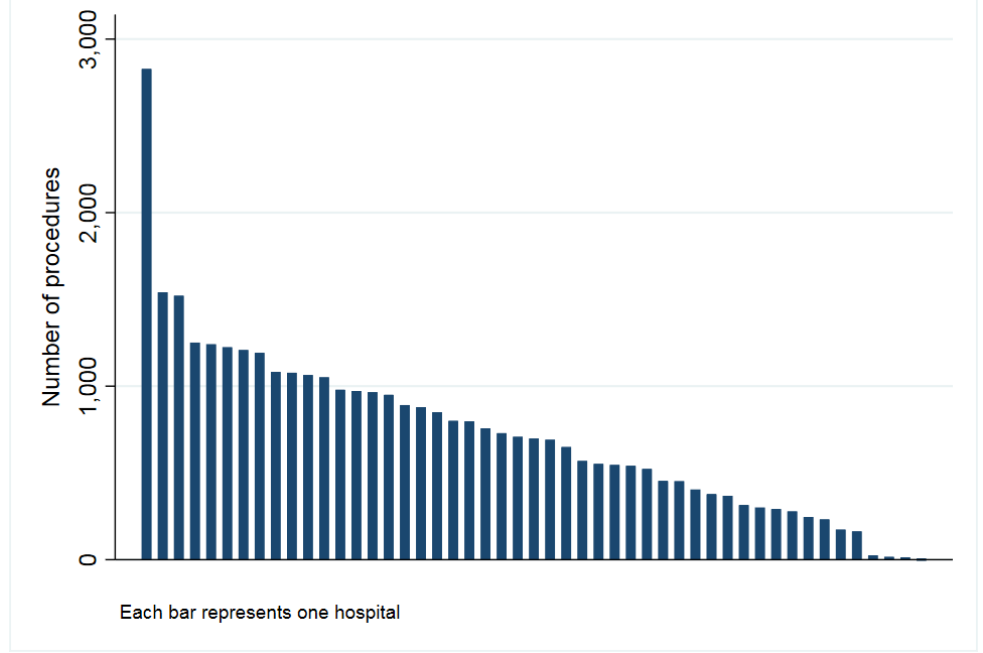
Figure 2. Number of knee procedures by hospital (2005–2016).